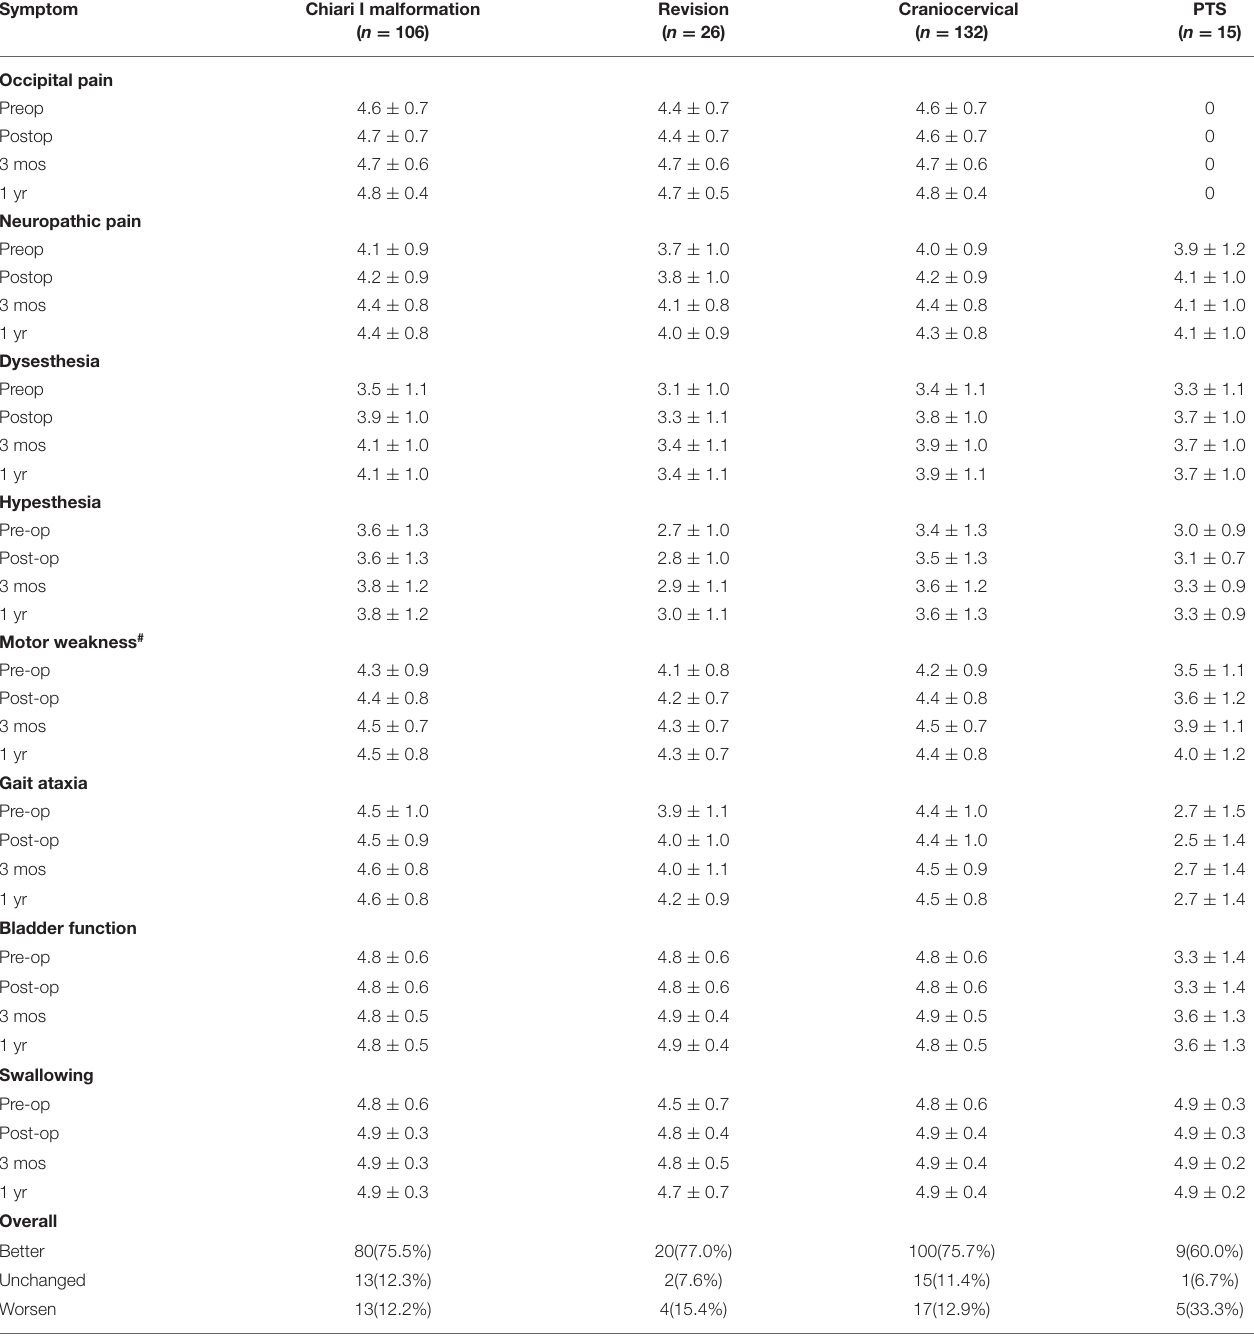
TABLE 2 | Changes in related symptoms of syringomyelia caused by different aetiologies. Symptom Chiari I malformation ( n =